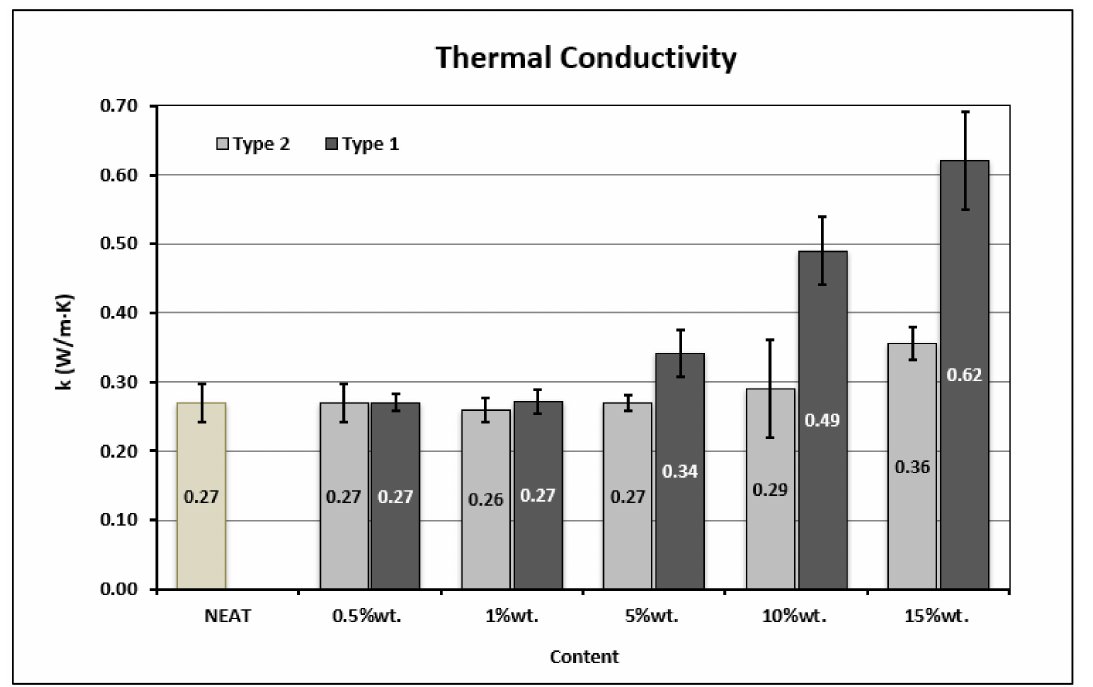
Figure 5. Thermal conductivity of the developed